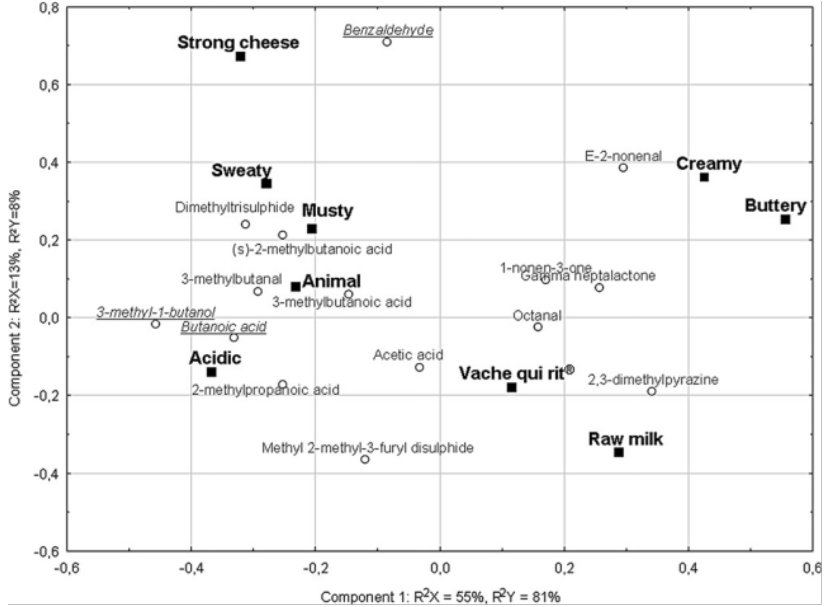
Figure 7. Bi-plot of the two first components as a result of PLS analysis of the sensory profiles (Y matrix, black) and the GC-O intensity measurements for the odor-active compounds (X matrix, grey) (reprinted from [173] with permission from